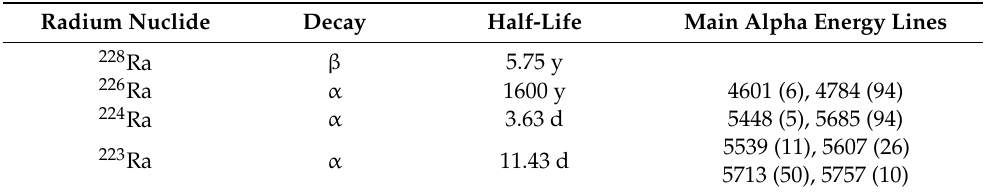
Table 4. Properties of naturally occurring radium nuclides. Alpha energy lines in keV with emission probability in %. All data from